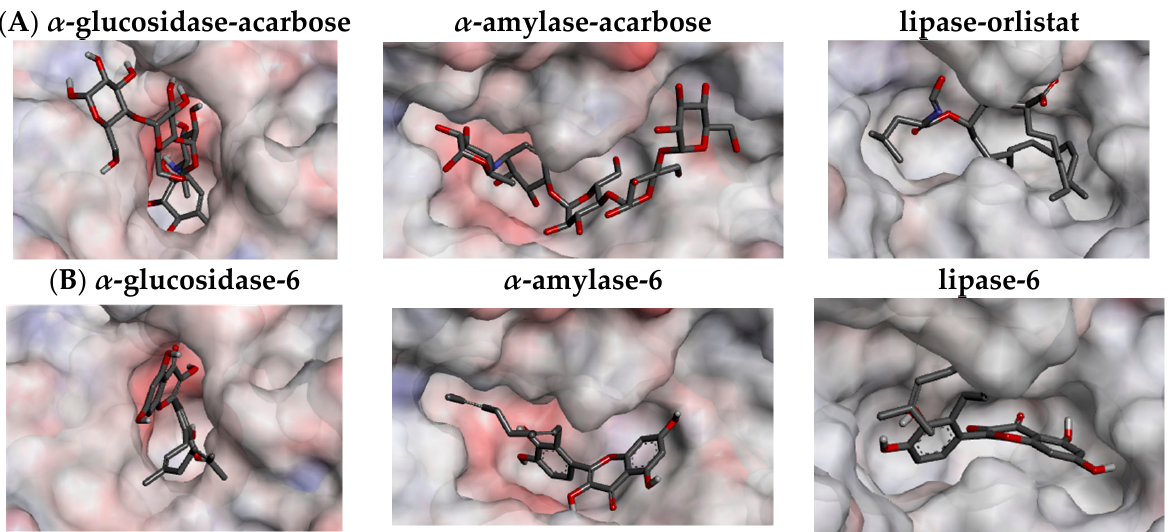
Figure 4. Binding pocket of α -glucosidase (2ZQ0), α -amylase (2QV4), and lipase (6KSM) with their ligands (enzyme surface shows interpolated charge with positive in blue, zero in white, and negative in red). ( A ) Positive controls; and ( B ) Compound 6 .